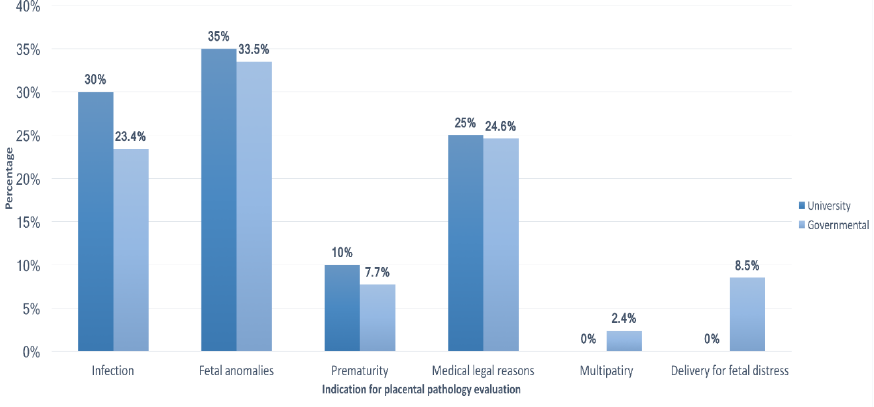
Figure 3. Indication for pathological examination of placentas in relation to different institutions when the CAP guidelines were not used.